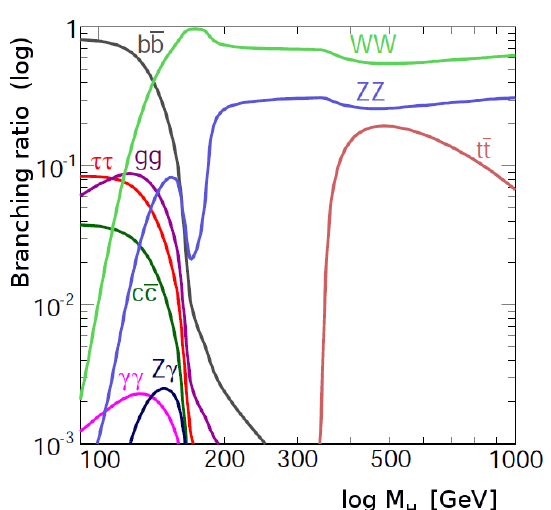
Figure 3. The branching fractions of the various decay channels of the Higgs boson as predicted by the standard model [8]. Both axes are logarithmic. For m H ≤ 120 GeV/ c 2 , the H → bb decay channel dominates. Note how small the probabilities of the reactions H → γγ and H → ZZ → 4 charged leptons are, leading to the discovery of the Higgs boson at the